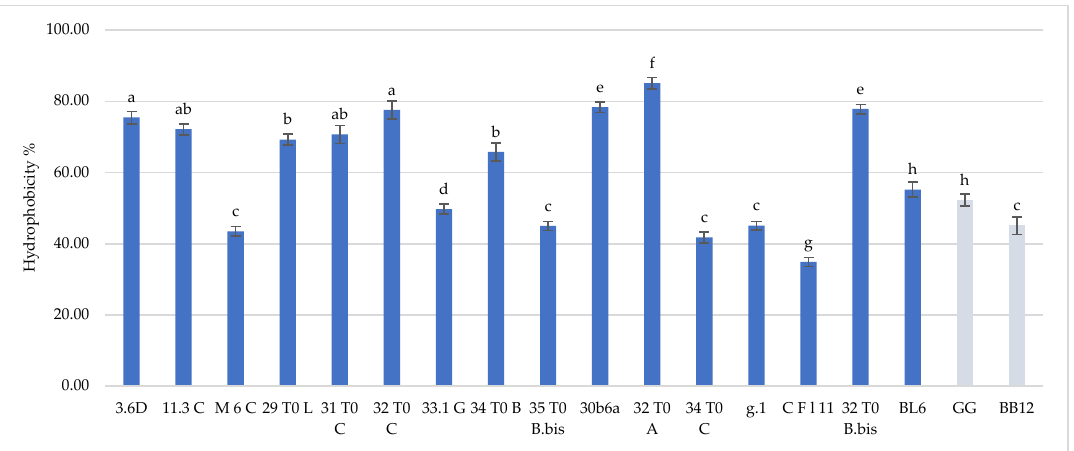
Figure 1. Cell hydrophobicity of L. plantarum 3.6D, 11.3 C, M 6 C, 29 T0 L, 31 T0 C, 32 T0 C, 33.1 G, 34 T0 B, 35 T0 B.Bis, 30 b6 A, L. gasseri 32T0A, 34 T0C, g.1, C F l11, B. longum 32T0B.Bis, B. animalis BL6 and L. rhamnosus GG and B. animalis subsp. lactis BB-12. Results are reported as average ± SD. Samples equipped with different letters are significantly different ( p < 0.05).